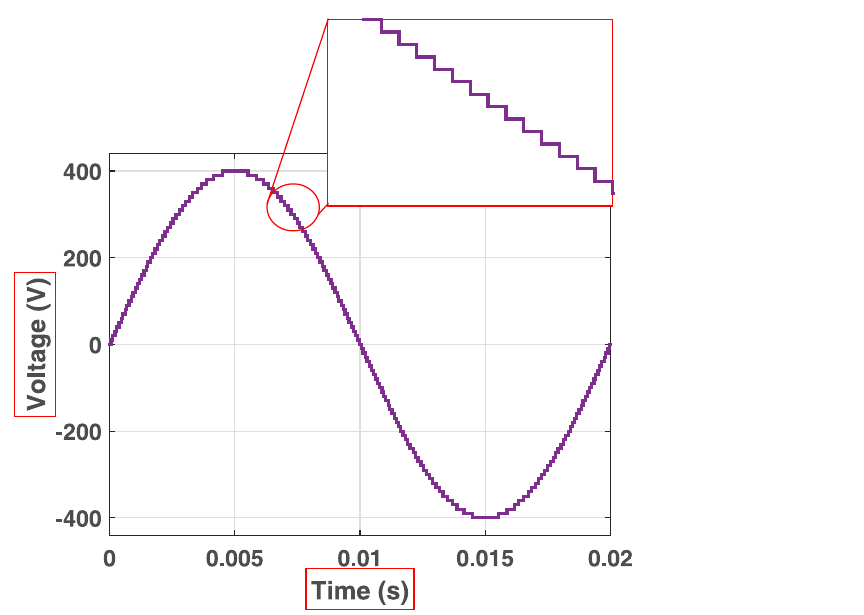
Fig 14. Output voltage of 81-level MWMLI with zoomed-in levels.